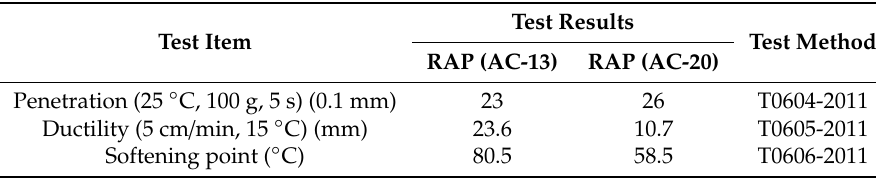
Table 5. Properties of bitumen recovered from the RAP.